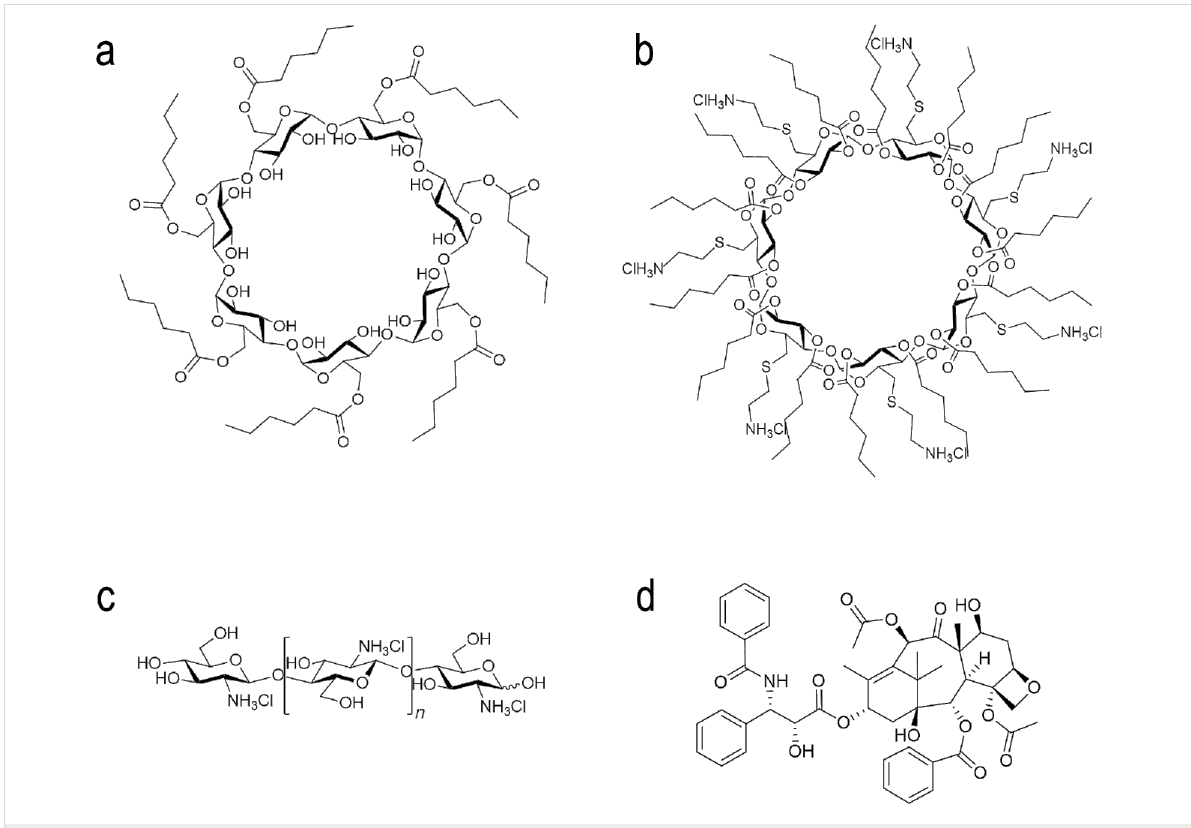
Figure 1: Schematic representation of amphiphilic 6OCapro β CD (a), amphiphilic PC β CDC6 (b), chitosan (c) and paclitaxel (d).